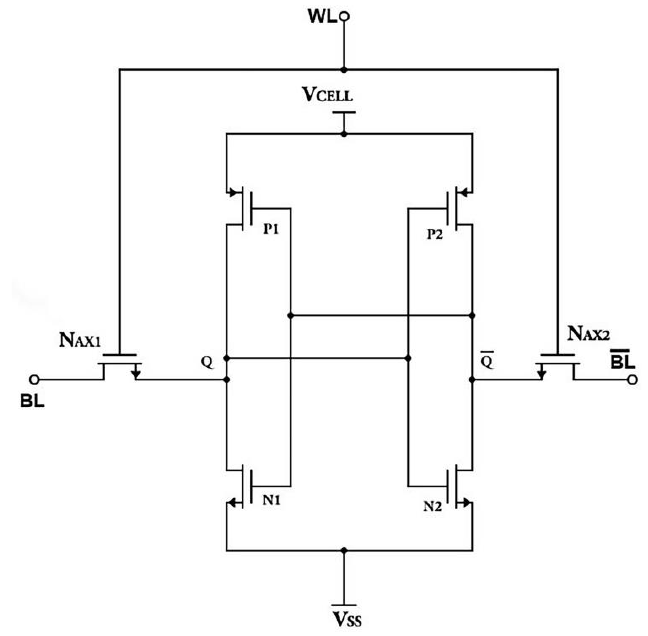
Figure 1. MOSFET-based Static Random Access Memory Cell.